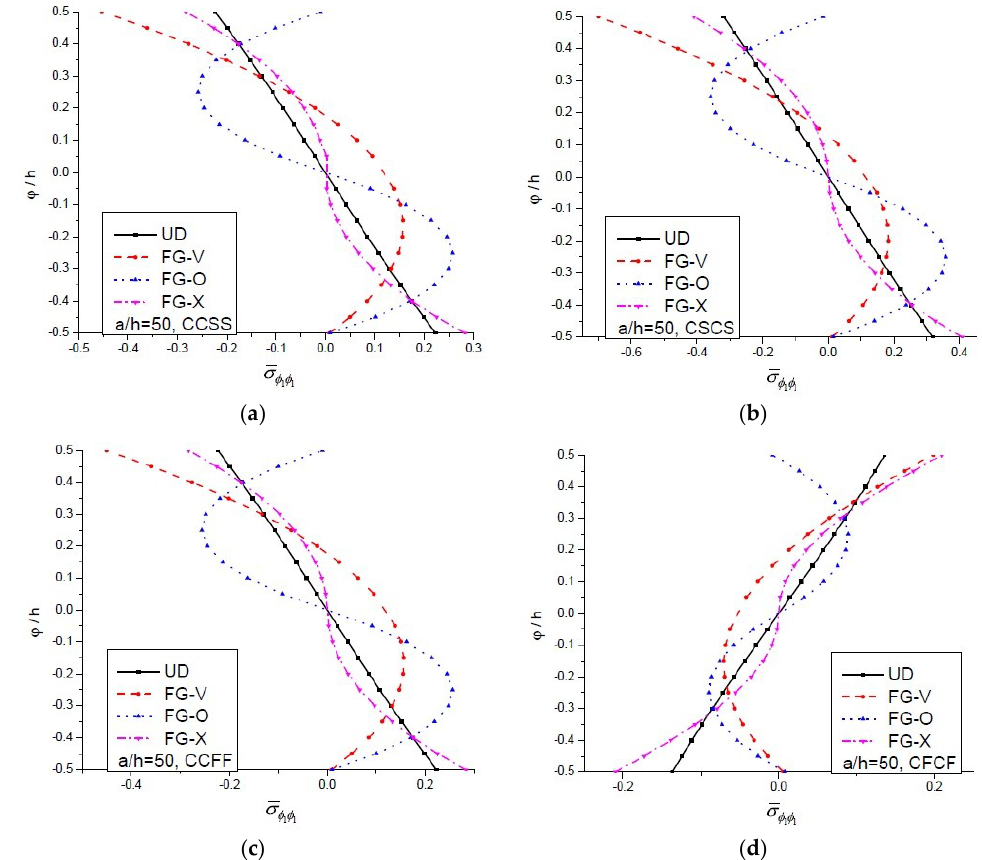
(cid:0) (cid:1) σ φ vs. ϕ / h ratio for an FG-CNT-reinforced  vs. /ℎ ratio for an FG-CNT-reinforced 1 φ 1